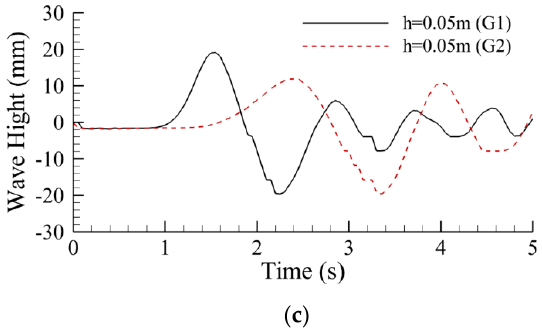
Figure 6. The temporal evolution of the water elevation in G 1 and G 2 with the subaerial landslide: ( a ) h = 0.25 m; ( b ) h = 0.15 m; and ( c ) h = 0.05 m.